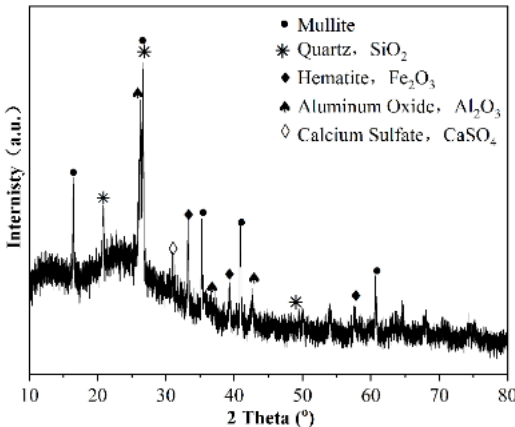
Figure 7. X-ray diffraction pattern of fly ash.